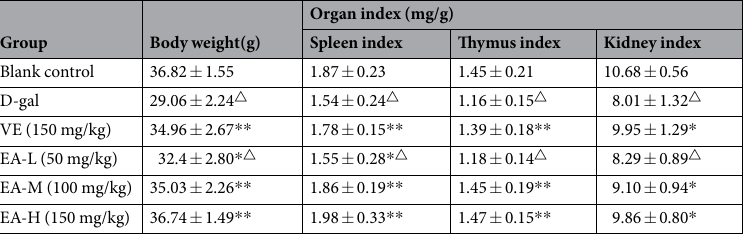
Table 1. Effects of EA on body weight and organ index in D-gal-treated rats Notes: Dates are given as mean ± SD (n = 8). △ P < 0.05 and △△ P < 0.01 vs blank control group. * P < 0.05 and ** P < 0.01 vs D-gal